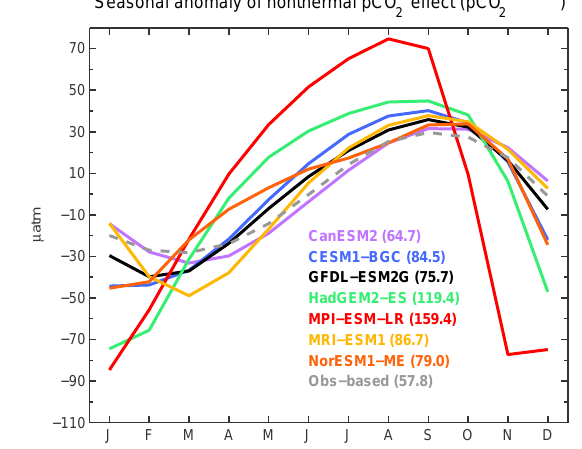
Figure 10. Anomalies of nonthermal p CO 2 seasonal cycle, ( p CO DIC + ALK ) as simulated by seven ESMs for the 2001–2010 2 period. The gray dashed line indicates the observation-based esti- mate of the p CO DIC + ALK seasonal cycle. The numbers within the 2 parentheses represent the amplitude for each model as well as for the observation-based